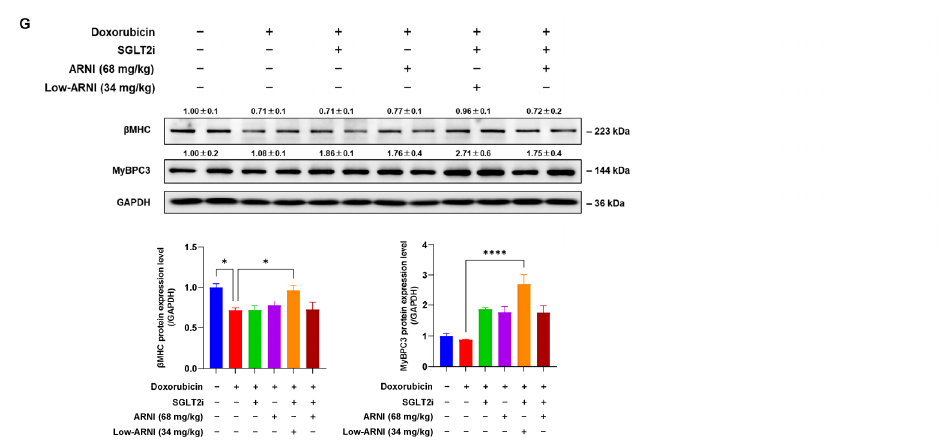
Figure 3. Protective effects of ARNI and SGLT2i treatment on doxorubicin-induced cardiotoxicity. ( A ) Whole-heart photograph. ( B ) The ratio of heart weight to tibia length (HW/TL) ( n = 7–8/group). ( C ) Representative hematoxylin and eosin staining. ( D ) Quantitative myofibrillar thickness ( n = 6–7/group) ( E ) Representative cytoplasmic vacuolization. ( F ) Quantitative number of cytoplasmic vacuoles ( n = 6–7/group). ( G ) Representative immunoblots of β MHC, MyBPC3, and GAPDH and graphical quantification at 9 weeks after doxorubicin injection in indicated experimental groups ( n = 4–5/group). * p < 0.05, **** p < 0.0001.